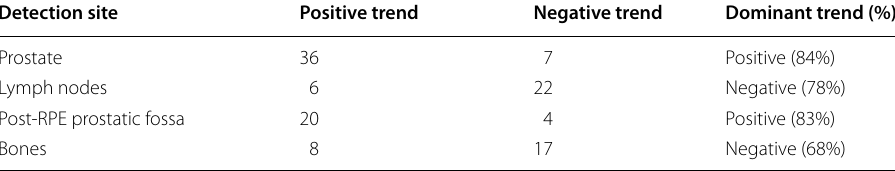
Table 1 Overview of all analysed lesions sorted by detection site and their dynamics trends Detection site Positive trend Negative trend Dominant trend (%) Prostate Post-RPE prostatic fossa